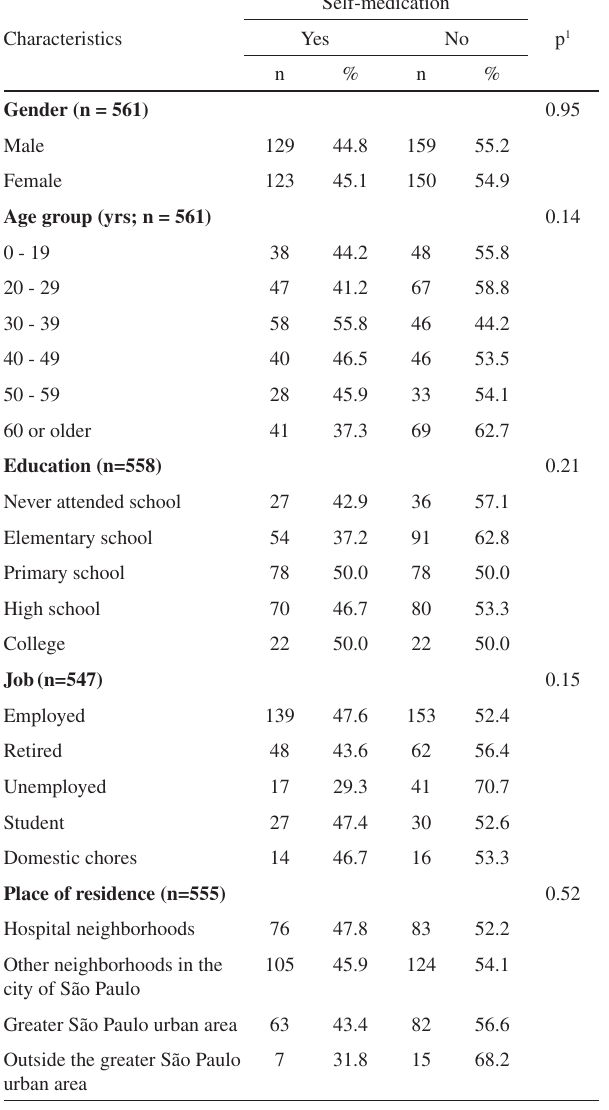
Table 3 – Use of self-medication to treat ocular conditions according to socio-demographic characteristics